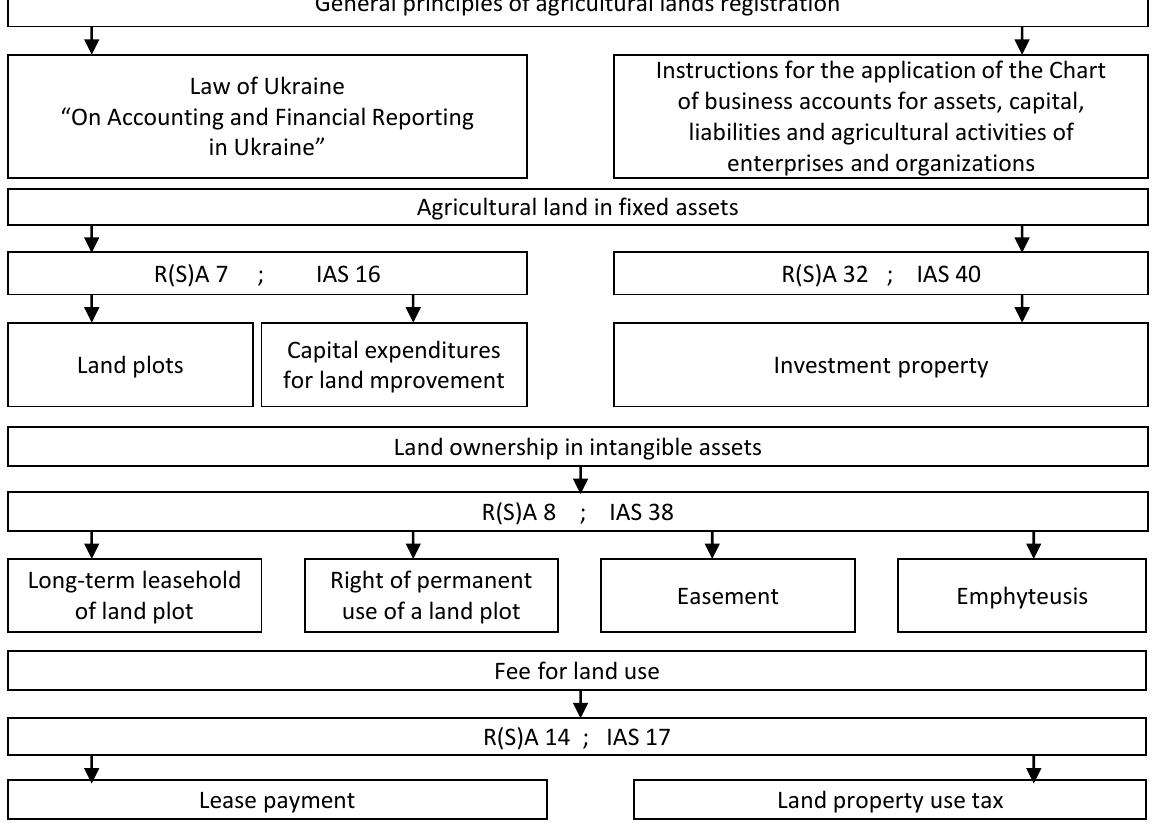
Figure 2. Regulatory legal framework for land registration of agricultural